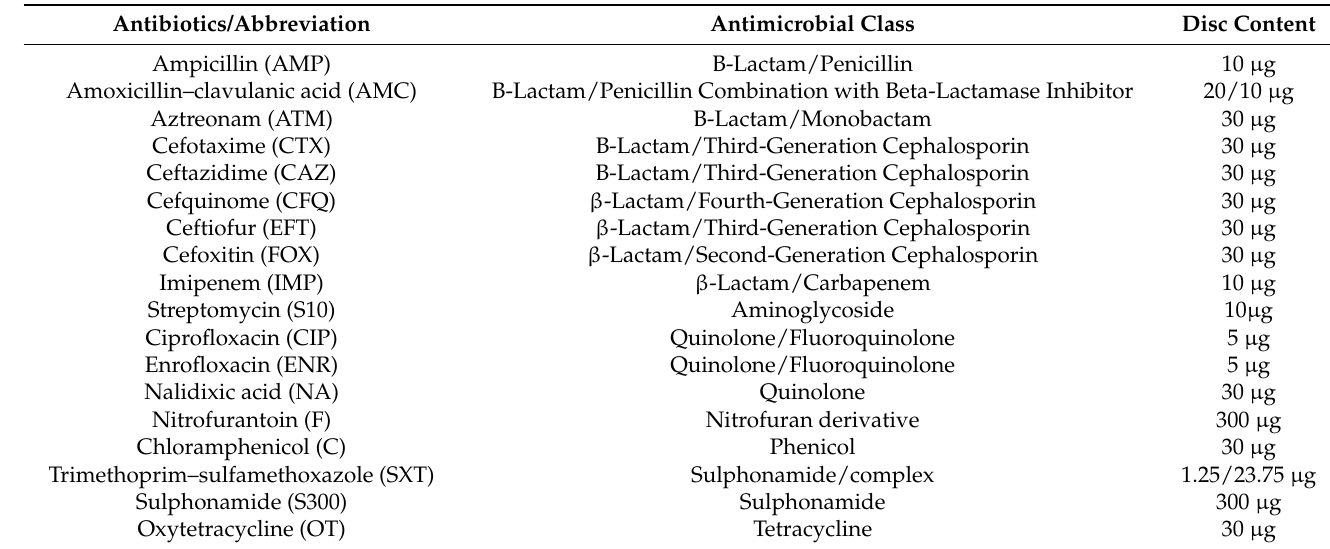
Table 2. Antimicrobial assay discs, abbreviations, classes and amount of antibiotic contained in each